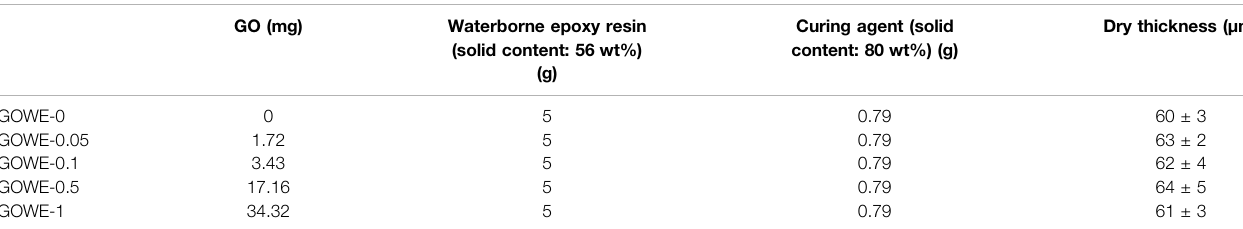
TABLE 1 | Formulation of graphene oxide-hybridized waterborne epoxy